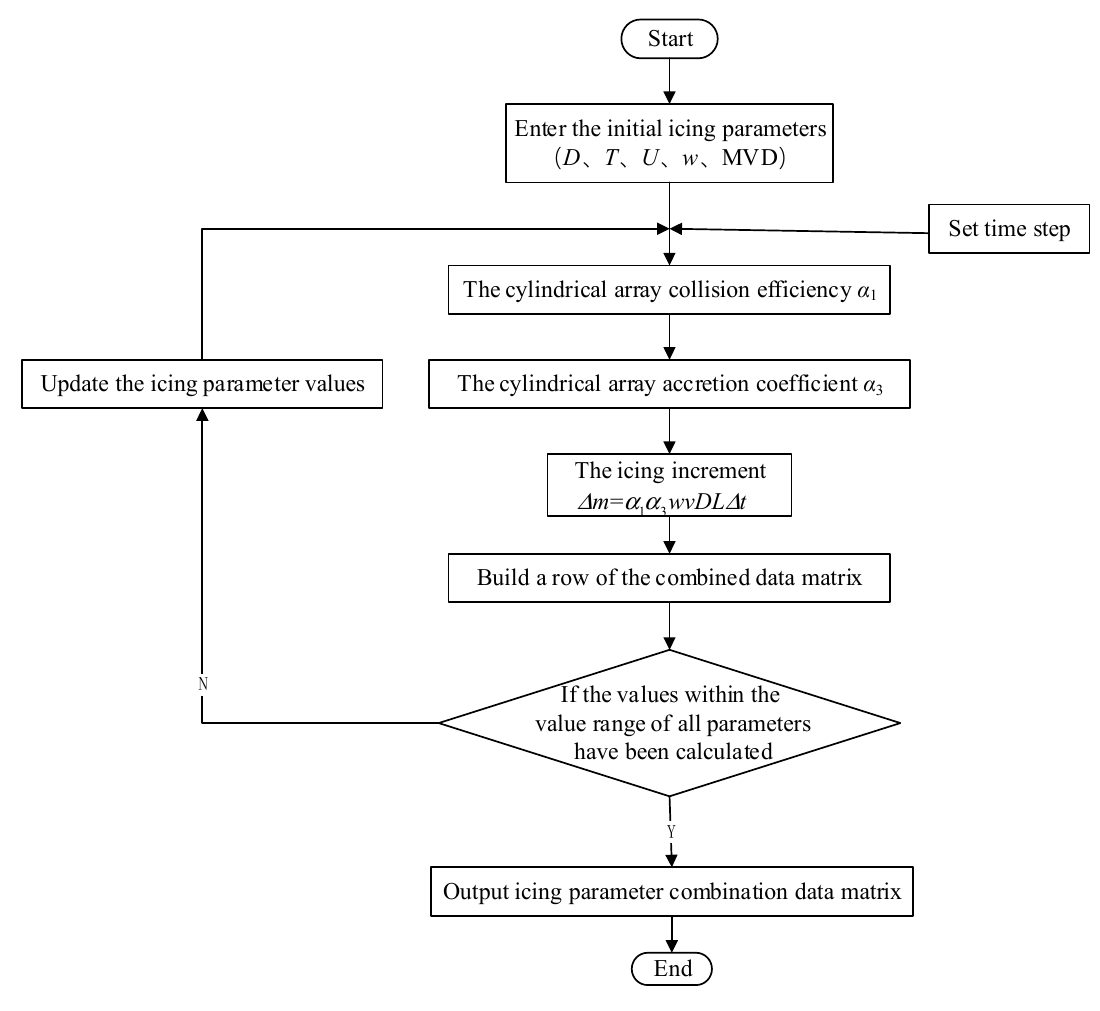
Figure 4. Flow chart of matrix database construction.